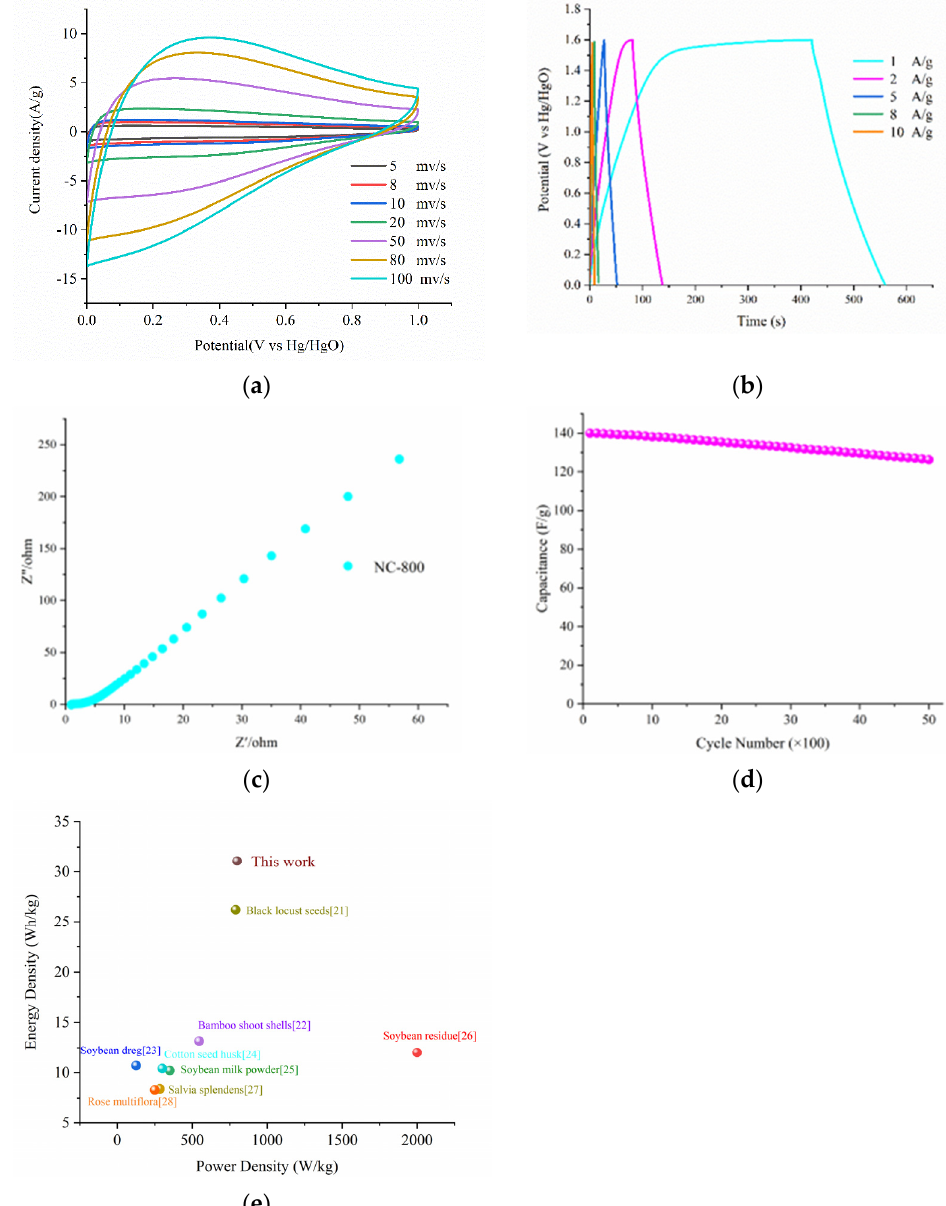
Figure 3. ( a ) CV curves of the NC-800//NC-800 at different scan rates (2-100 mv/s); ( b ) GCD curves of NC-800//NC-800 at different current densities (1-10 A/g); ( c ) Nyquist plots of NC-800//NC-800; ( d ) Cycling performance of NC-800//NC-800 electrode for 5000 cycles ( e ) Supercapacitor performance of plant-based heteroatom-doped biomass carbon electrodes.